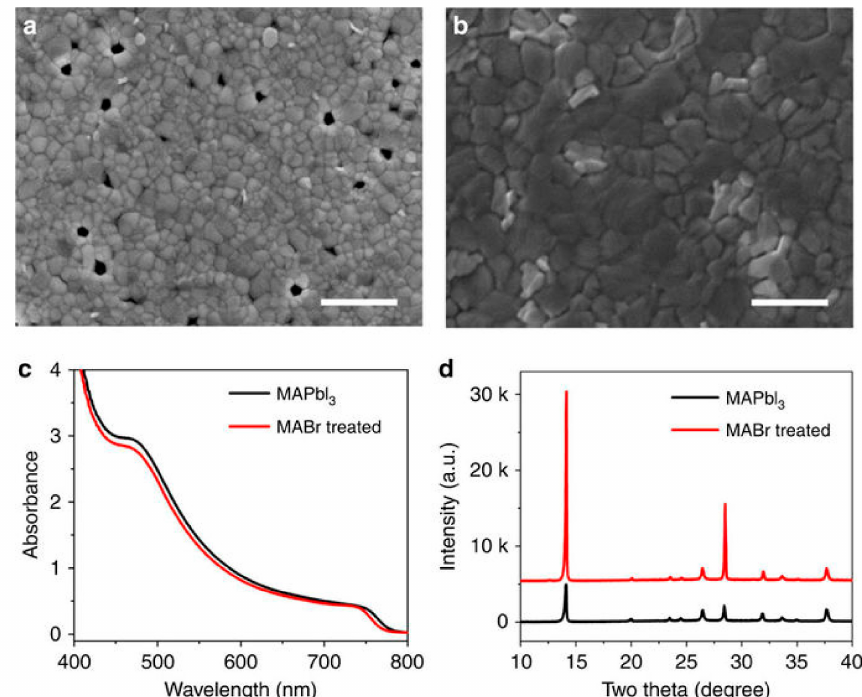
Figure 12. Top view of the scanning electron microscope (SEM) images of ( a ) MAPbI3 and ( b ) MABr-treated MAPbI 3 films. Scale bars, 1 µ m. Comparison of ( c ) ultraviolet–visible (UV-vis) absorption spectra and ( d ) XRD patterns of MAPbI 3 films with and without MABr